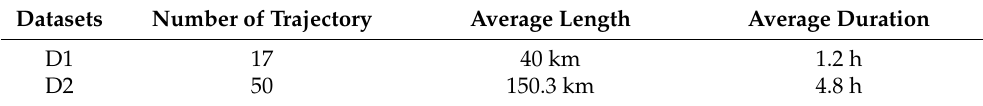
Table 1. Dataset metadata.